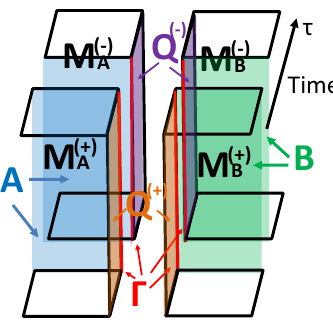
Figure 7 . Separating a space into four subspaces M (+) in the upper and lower directions without encountering any boundaries. The boundary of M ( (cid:6) ) (and M ( (cid:6) ) ) consists of A [ Q ( (cid:6) ) (and B [ Q ( (cid:6) ) ). The four subspaces have a common surface B